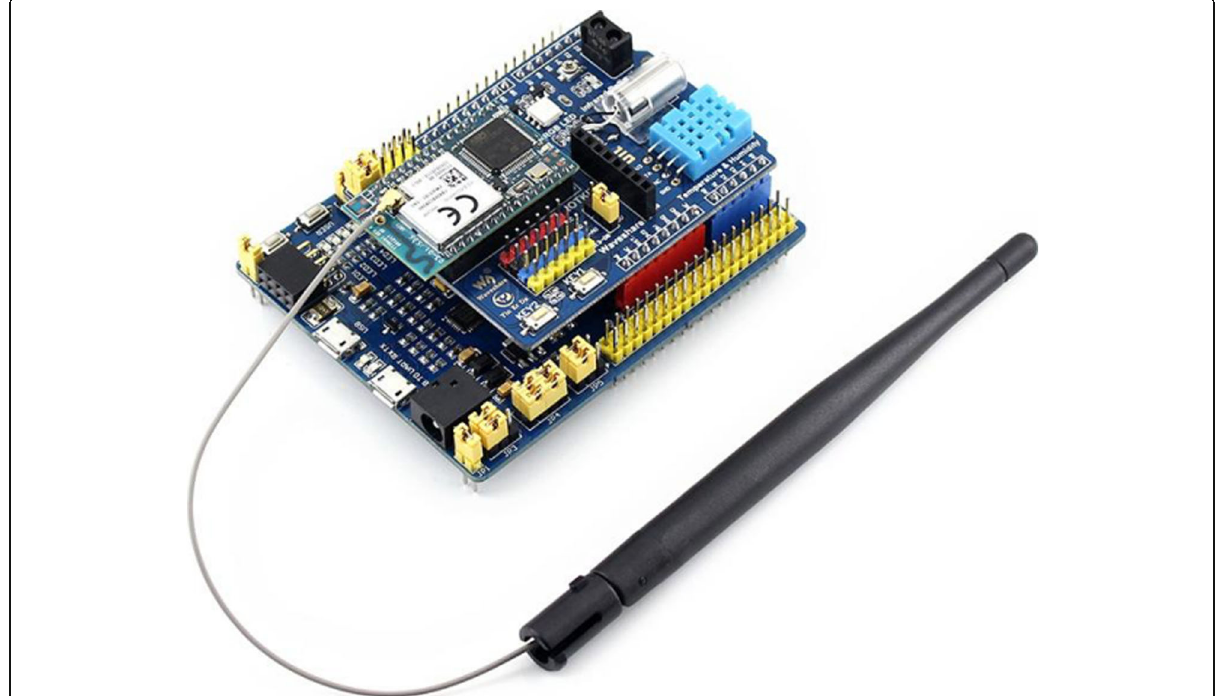
Fig. 2 Arduino system employed for communication with the base station, likewise for message delivery. The system mentioned above is based on the Arduino Uno board and the four-band GPRS module, which includes a HiLo SAGEM communication module (see Fig. 2)